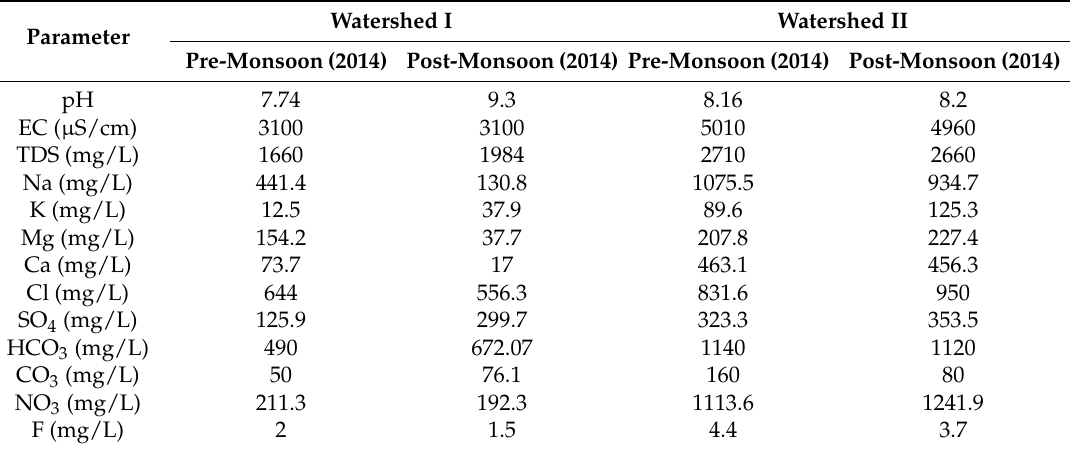
Table 1. Groundwater quality across watersheds in Andhra Pradesh,